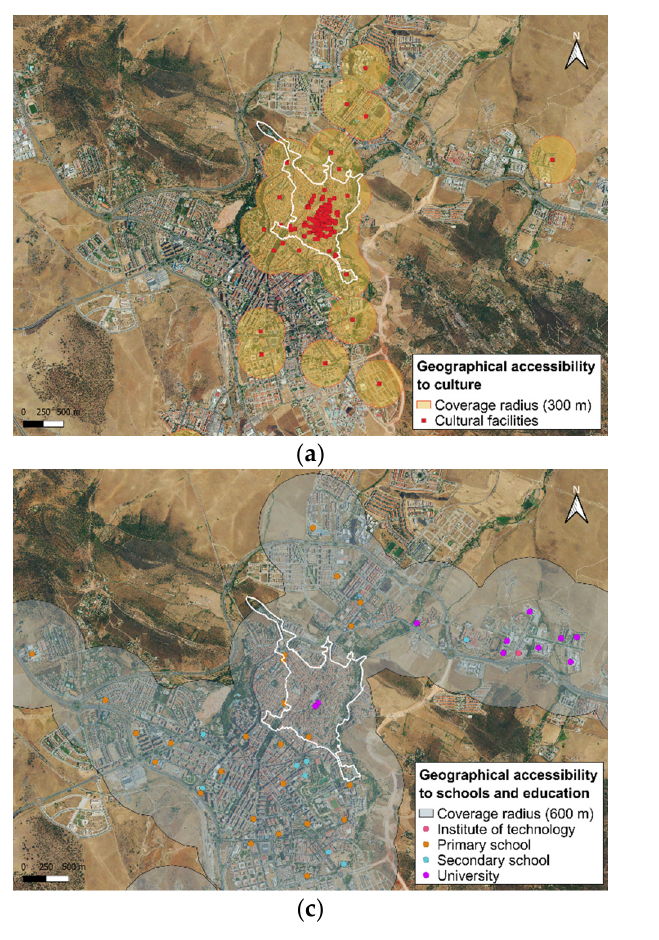
Figure 8. Map of geographical accessibility to household waste recycling centre (HWRC).